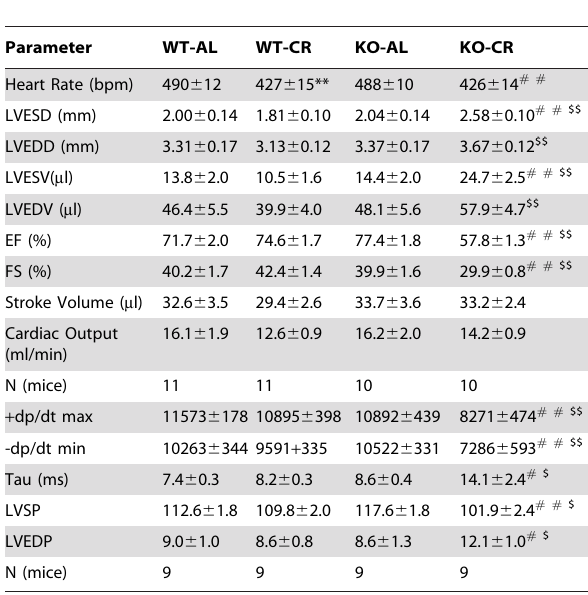
Table 3. Cardiac echocardiographic and hemodynamics data in WT and AMPK a 2 KO mice with or without caloric restriction.